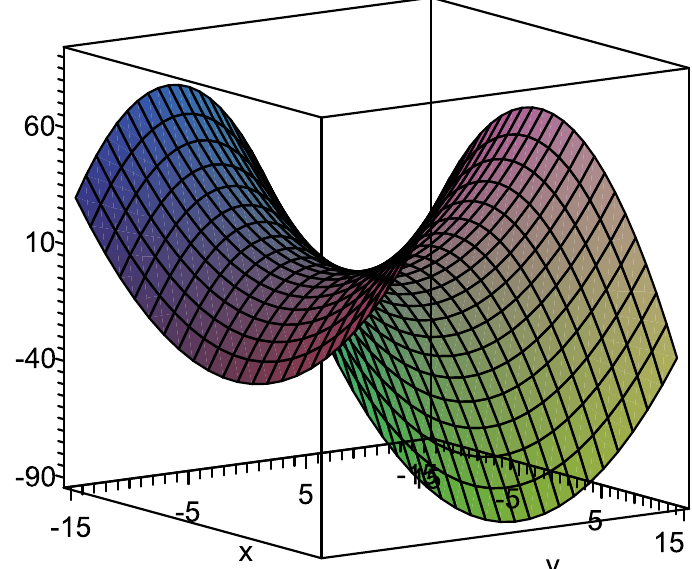
Figure 4. the pseudonull hypersurface PN H .